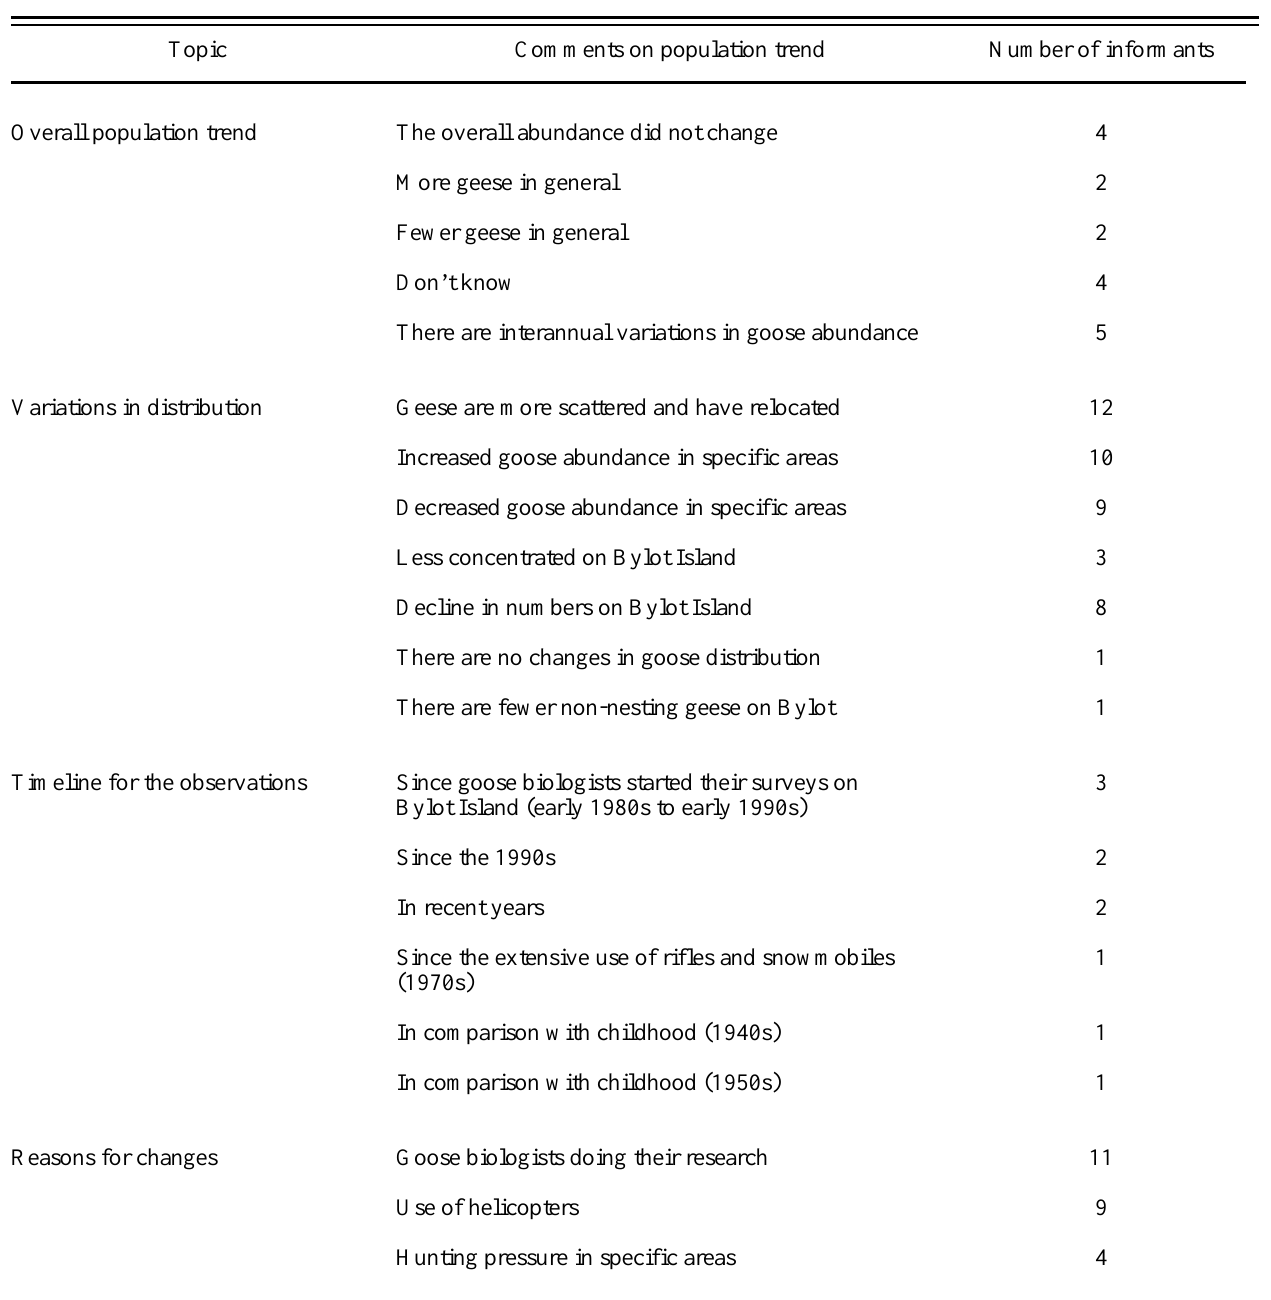
Table 2 . Summary of Inuit traditional ecological knowledge pertaining to changes in the abundance and distribution of greater snow geese ( Chen caerulescens atlantica ), as reported by 13 and 15 local experts from Mittimatalik, Nunavut, Canada, interviewed in this study, respectively. The temporal scale includes knowledge dating back to the 1940s, and the spatial scale is Bylot Island and the northern part of adjacent Baffin Island. Timelines for the observations based on reports from 10 experts and reasons perceived to have caused the changes based on reports by 14 experts are also